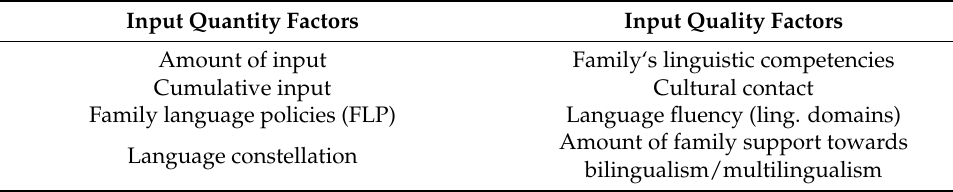
Table 3. Input quantity and quality factors from the parental questionnaire 12